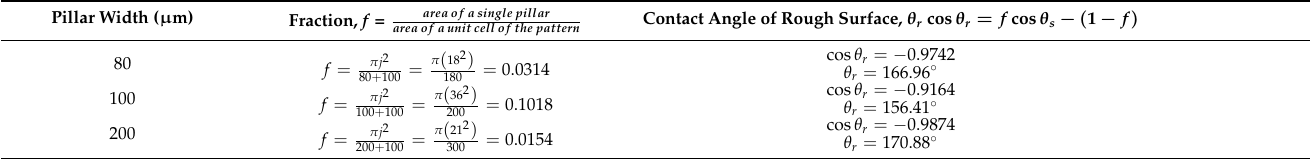
Table 2. The calculation of water contact angle on a rough